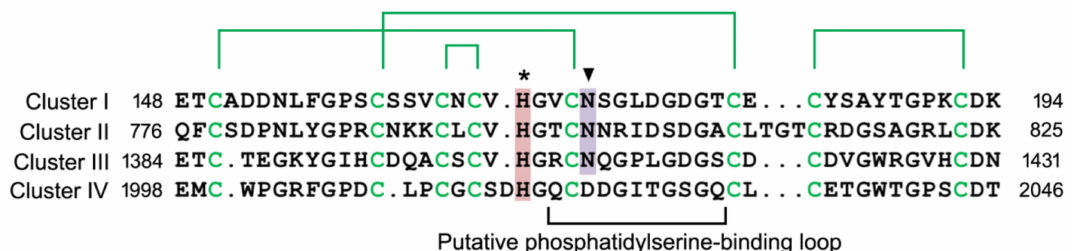
Figure 2. The amino acid sequences of the second atypical EGF-like domains in the four clusters of stabilin-2. Disulfide bonds in atypical EGF-like domain are indicated by green lines. Arrowhead indicates conserved asparagine, which is important for phosphatidylserine recognition by a coordinating Ca 2 + ion. Asterisk indicates conserved histidine that is critical for enhancement of phagocytic activity in low pH